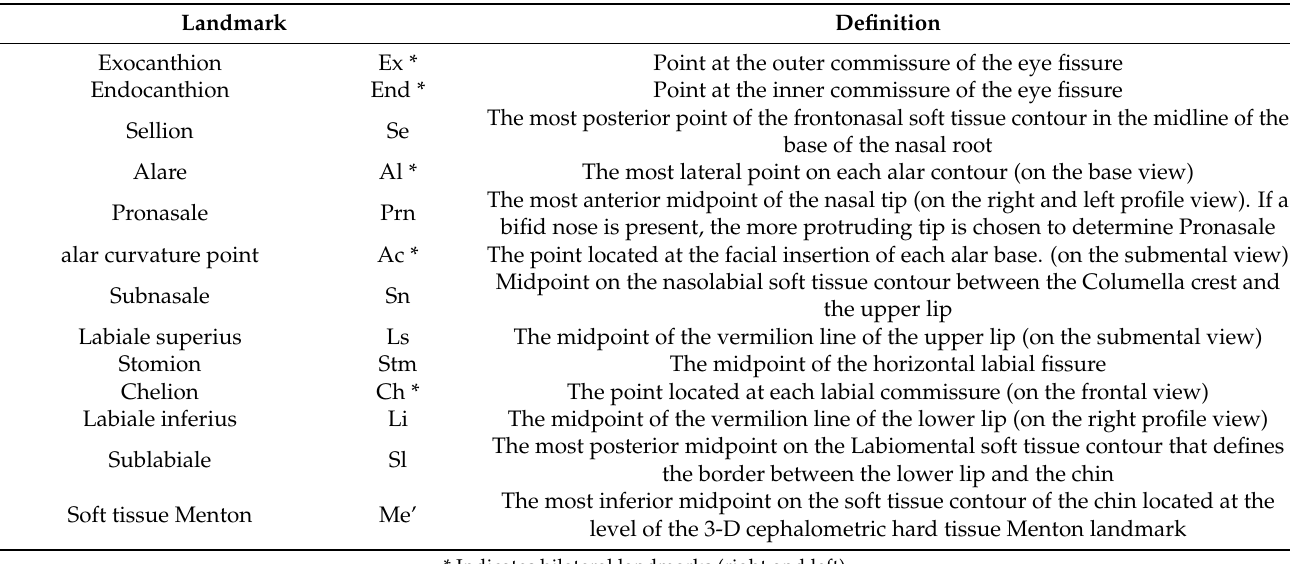
Table 1. Definition of the facial landmarks used in our study.